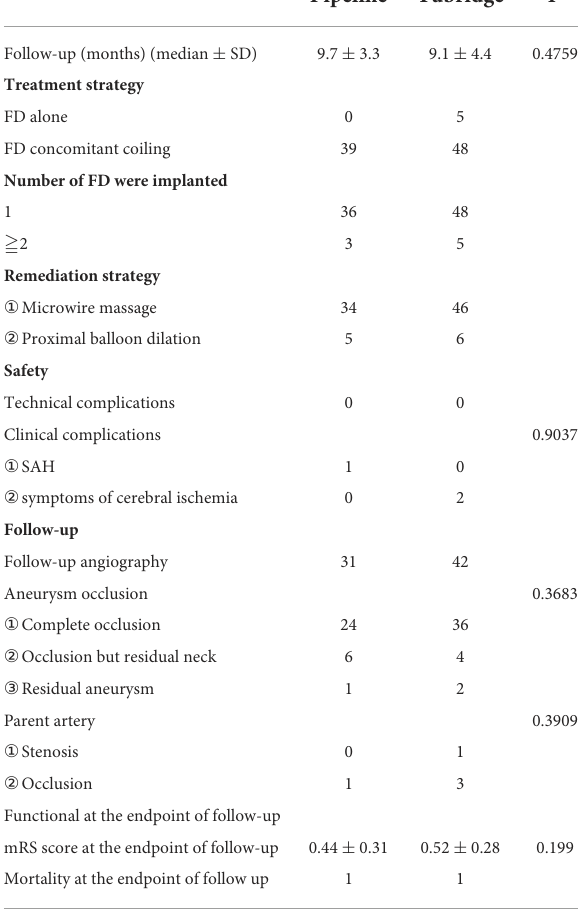
TABLE 2 Outcome of the patients with intracranial wide-necked aneurysms who were treated with FDs. Pipeline